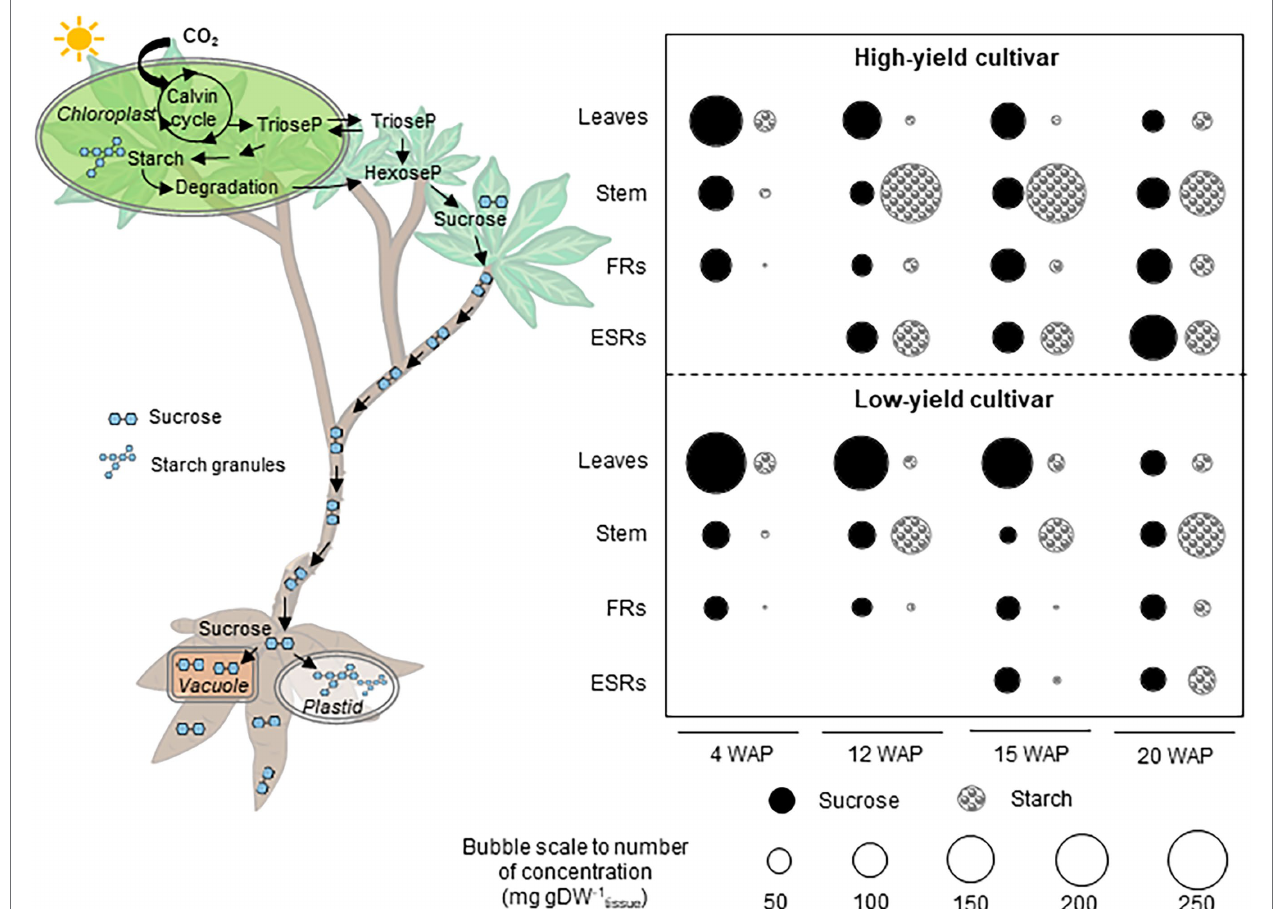
FIGURE 8 | Scheme summarizing the shoot-to-root carbon partitioning in high- and low-yield cassava varieties at various developmental stages. The partitioning of carbon into shoots and roots was determined from changes in sucrose and starch contents. ESRs, early storage roots; FRs, fibrous roots; and WAP, week after